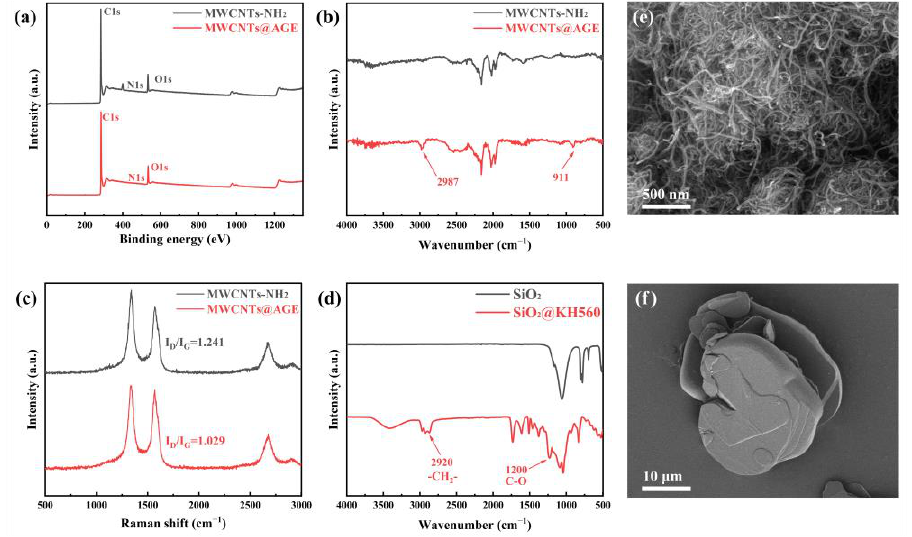
Figure 2. Characterization of SiO 2 , SiO 2 @KH560, MWCNTs, and MWCNTs@AGE. ( a – c ) XPS general spectra, FT-IR spectra, and Raman spectra of MWCNTs and MWCNTs@AGE; ( d ) FT-IR spectra of SiO 2 and SiO 2 @KH560; ( e , f ) SEM images of MWCNTs and h-BN.